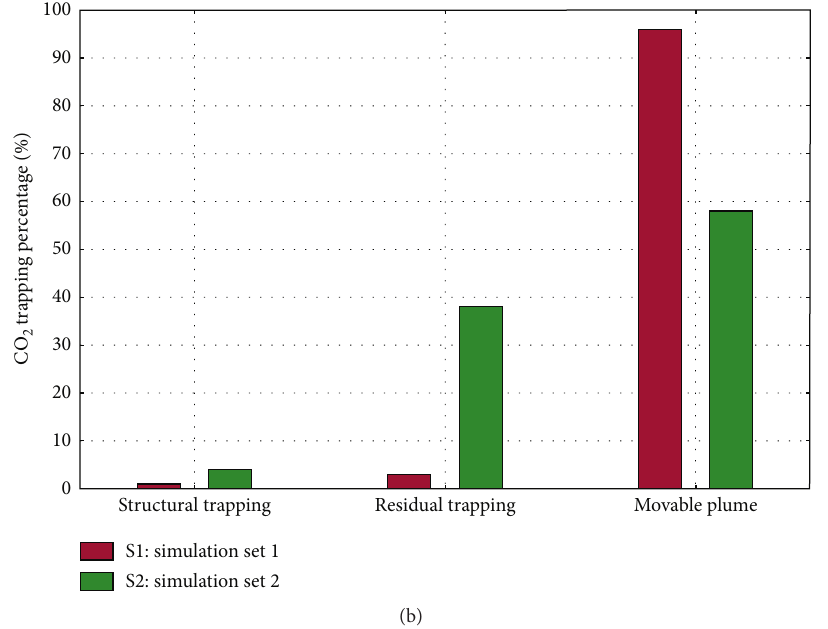
Figure 8: (a) Sweeping efficiency comparison for different porosity and permeability ranges. (b) Comparison of the percentage of structural trapping, residual trapping, and movable plume between the two petrophysical